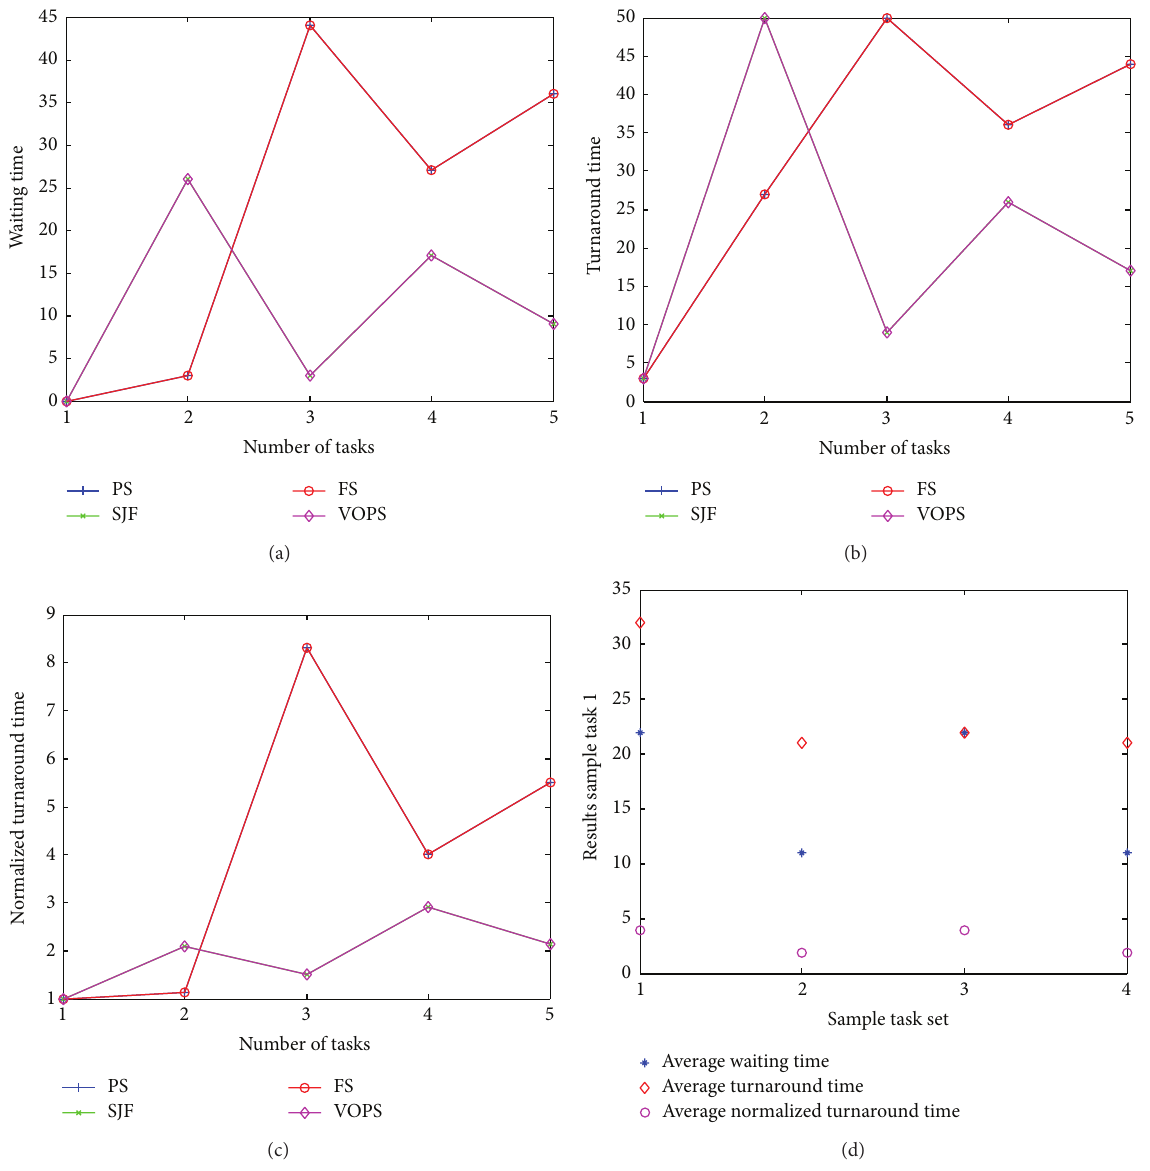
Figure 6: (a) Waiting time for sample task set 1. (b) Turnaround time for sample task set 1. (c) Normalized turnaround time for sample task set 1. (d) Results of sample task 1.